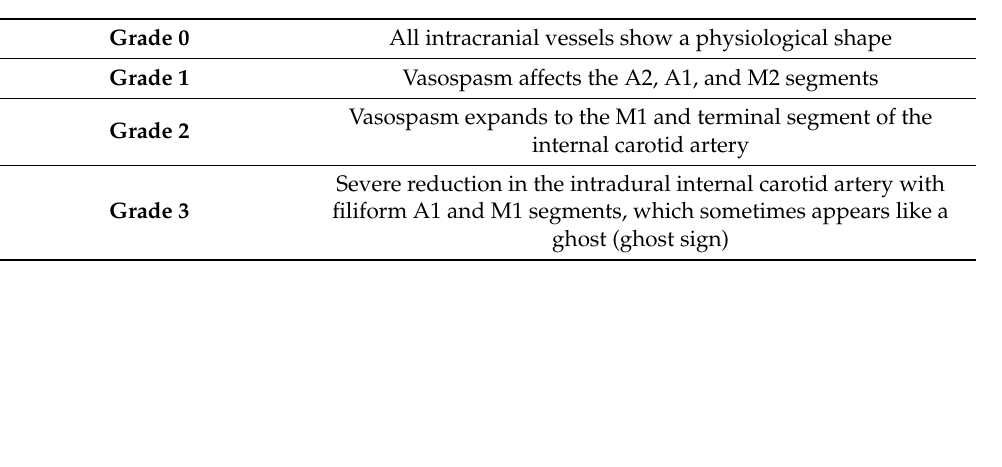
Table 1. Visual classification: Cerebral vasospasm grades